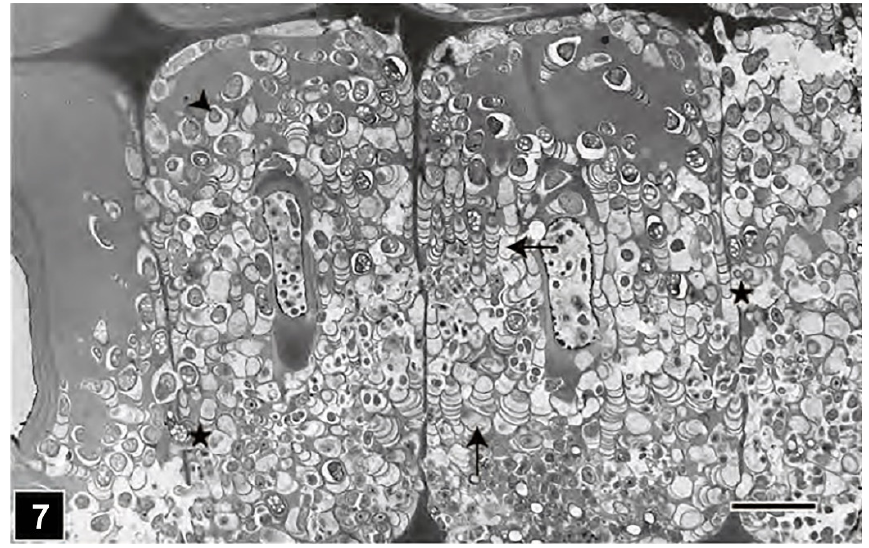
Figure 7. TEM of a transverse section through Homalium foetidum fibres attacked by tunnelling bacteria (arrowhead). All cell wall regions, including the highly lignified middle lamella (asterisks), are degraded, and the direction of tunnelling (arrows) is variable. Scale bar = 8 µm. The image is reproduced from Singh et al. (1987) J. Inst. Wood Sci.